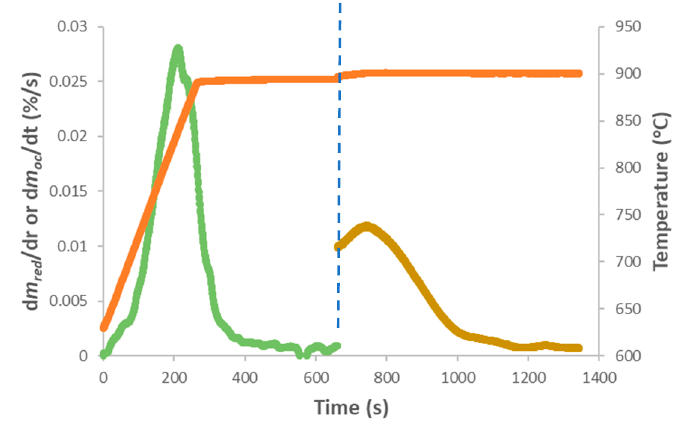
Figure 6. The reduction rate of Cu-OC with coal char in Ar ( dm red / dt ), reoxidation rate of reduced Cu-OC in air ( dm oc / dt ), and the reaction temperatures versus time at 900 °C in a TGA-QMS.